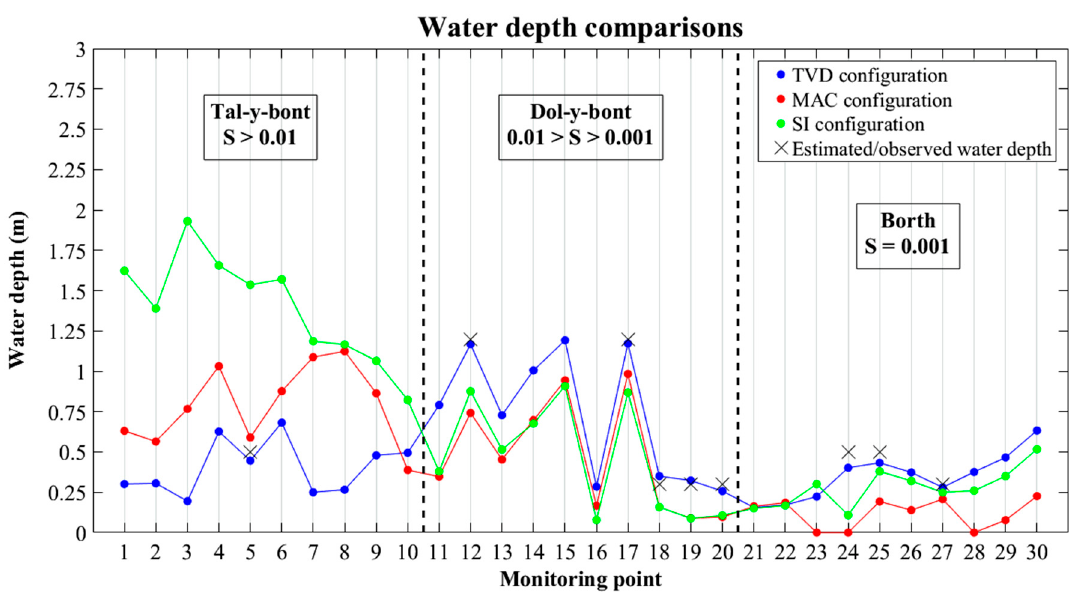
Figure 6. Predicted maximum water depths at the selected monitoring points for the TVD, MAC and SI model configurations. Table 3. The difference in water depth predictions between the simulated results and the estimated/observed values for the Borth study case expressed in terms of percentage errors.